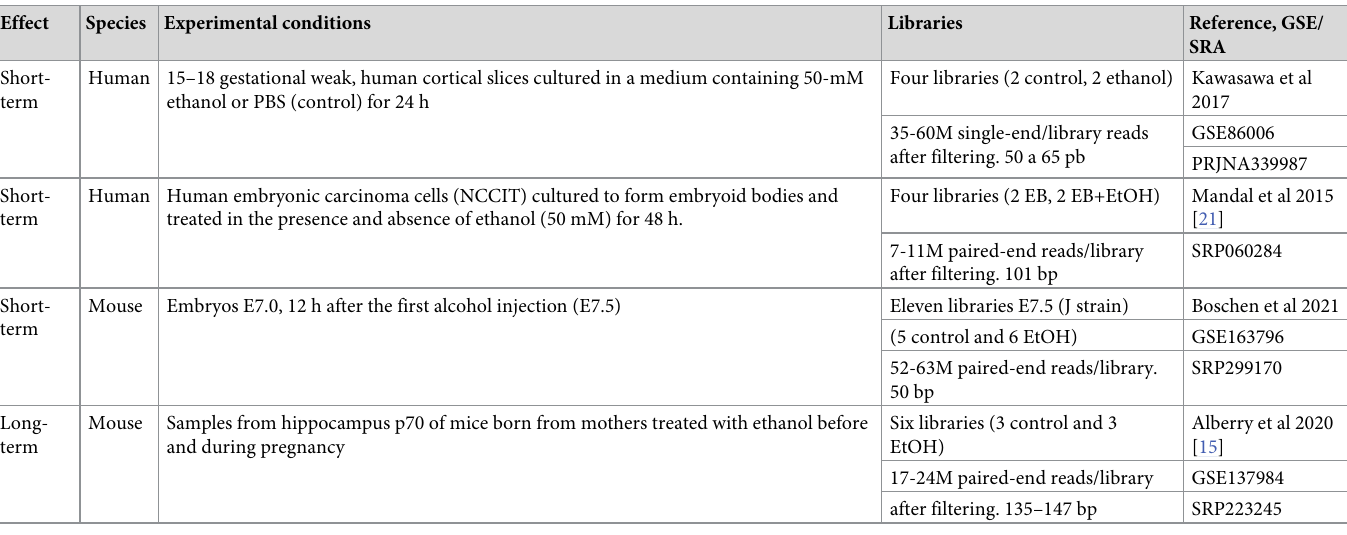
Table 1. Description of RNA-seq libraries